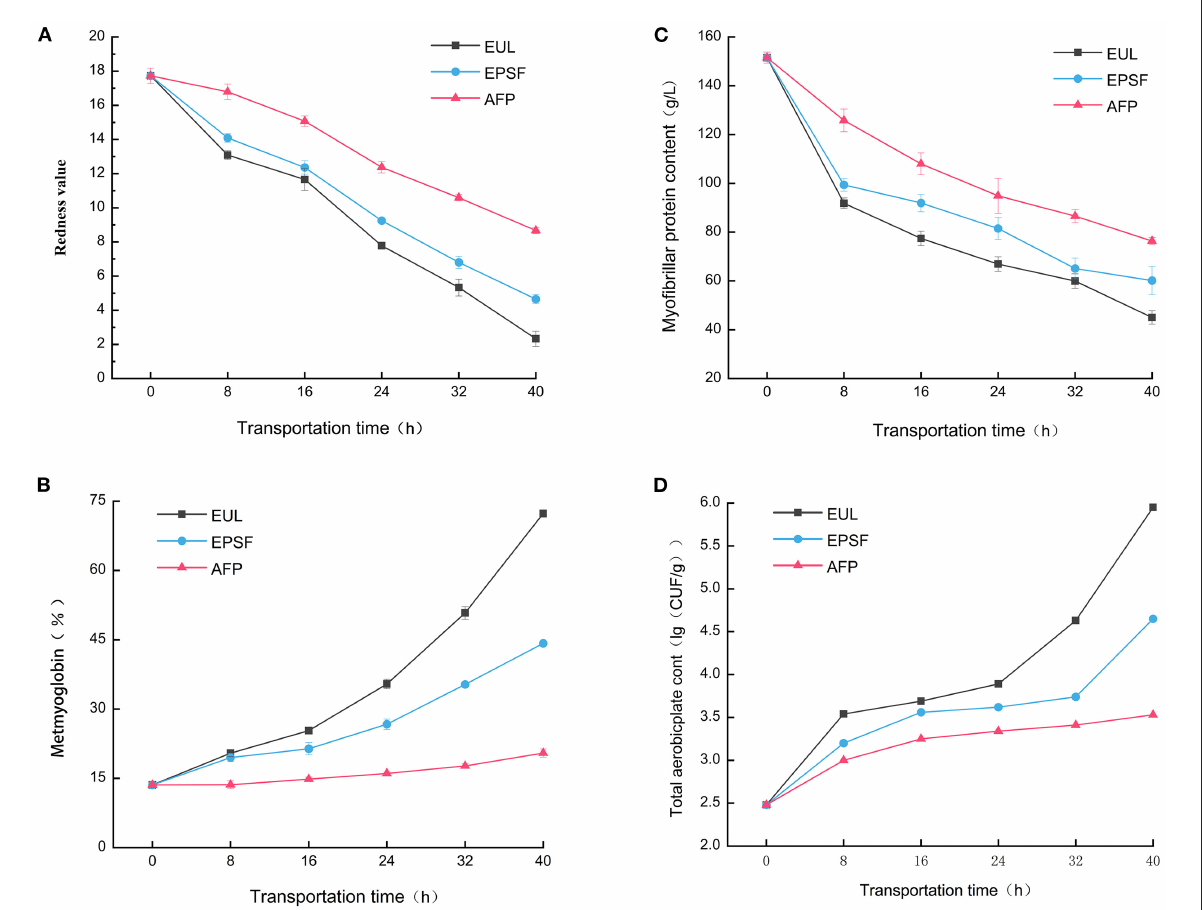
FIGURE3 Effects of various logistics packaging boxes on changes in the (A) redness value, (B) metmyoglobin, (C) myofibrillar protein content, and (D) total aerobic plate count. EUL, European logistics; EPSF, expanded polystyrene foam; AFP, aluminum foil paper. Data were obtained as the mean ± standard deviation ( n = 3).